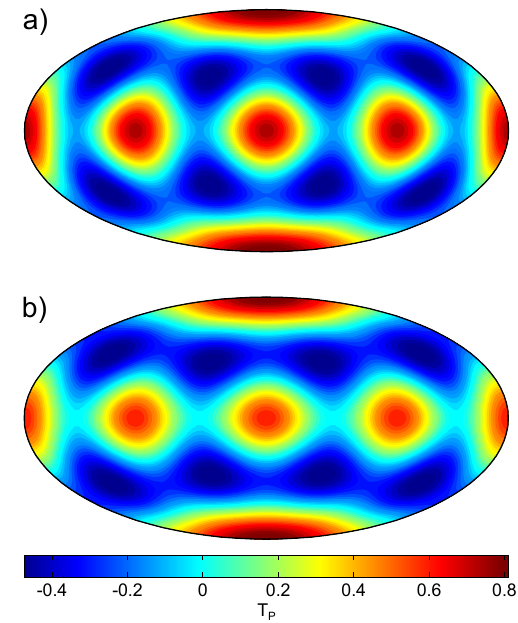
Figure 1. θ − λ temperature dependence of the cubic initial condi- tion (Eq. 9) for δ = 0 (a) and δ = 0 . 30 (b)